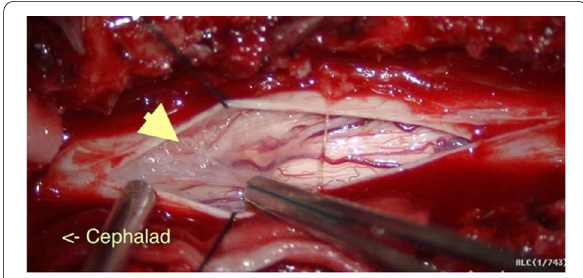
Fig. 2 Intraoperative image demonstrating the arachnoid web (yellow